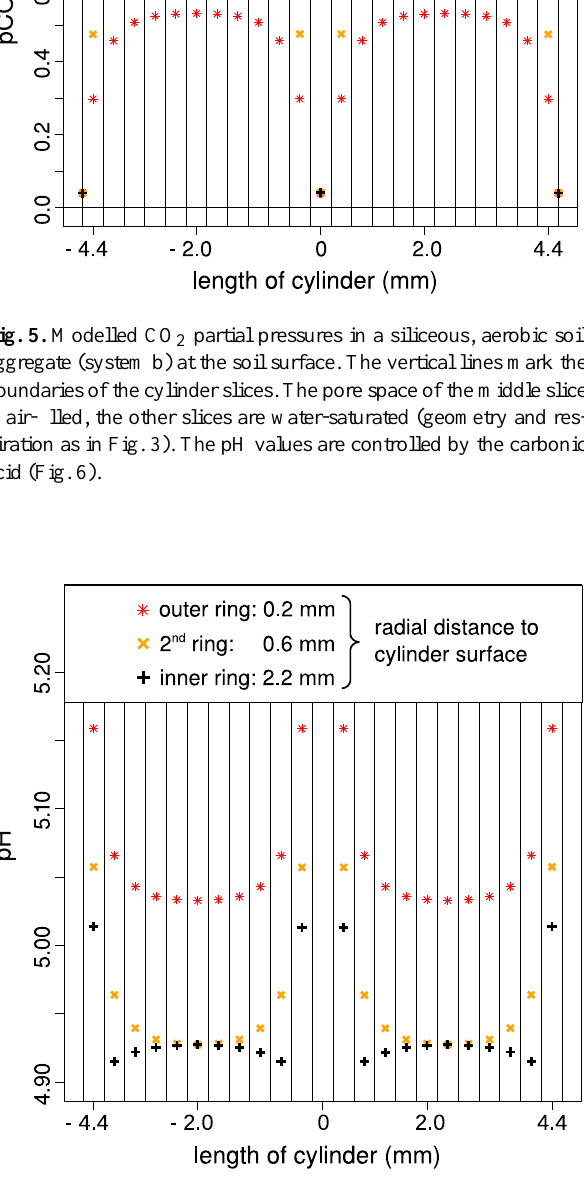
Fig. 6. pH values of the soil solution in the intra-aggregate pores, calculated for a “ CO 2 - H 2 O ”-system, using the CO 2 partial pressures shown in Fig. 5.